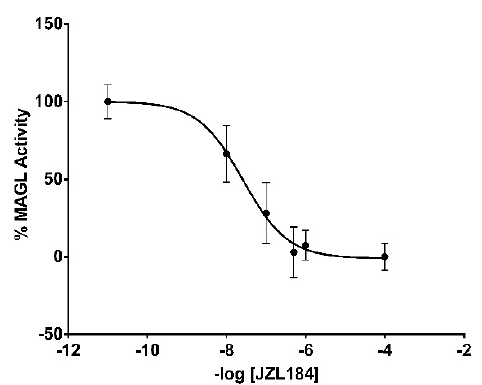
Figure 6. Concentration-dependent inhibition of JZL184 on MAGL. Data, reported as mean ± SD, are expressed as the percentage of controls (without JZL184). are expressed as the percentage of controls (without